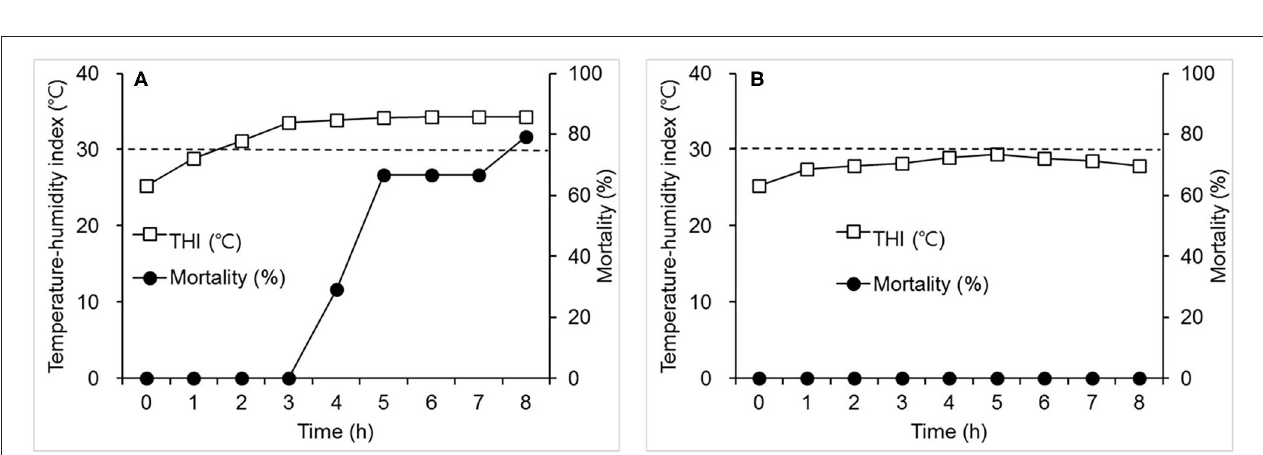
FIGURE 3 | The effects of a moderate increase in temperature-humidity index (THI) ( ◦ C) on mortality (%) in the laying hens used in Experiment 2. Hens were exposed to one of the two following THI conditions for 8h. (A) THI: 25.2–34.3; dry-bulb temperature (Tdb) ( ◦ C): 28.0–39.2; web-bulb temperature (Twb) ( ◦ C): 21.2–27.6; and relative humidity (RH) (%): 55.0–39.5. (B) THI: 25.2–29.4; Tdb: 28.0–32.5; Twb: 21.2–24.1; and RH: 55.0–40.0. Mortality was measured at the time points specified (h). The dot line indicates THI of 30 ◦ C. N = 24 for A and 12 for